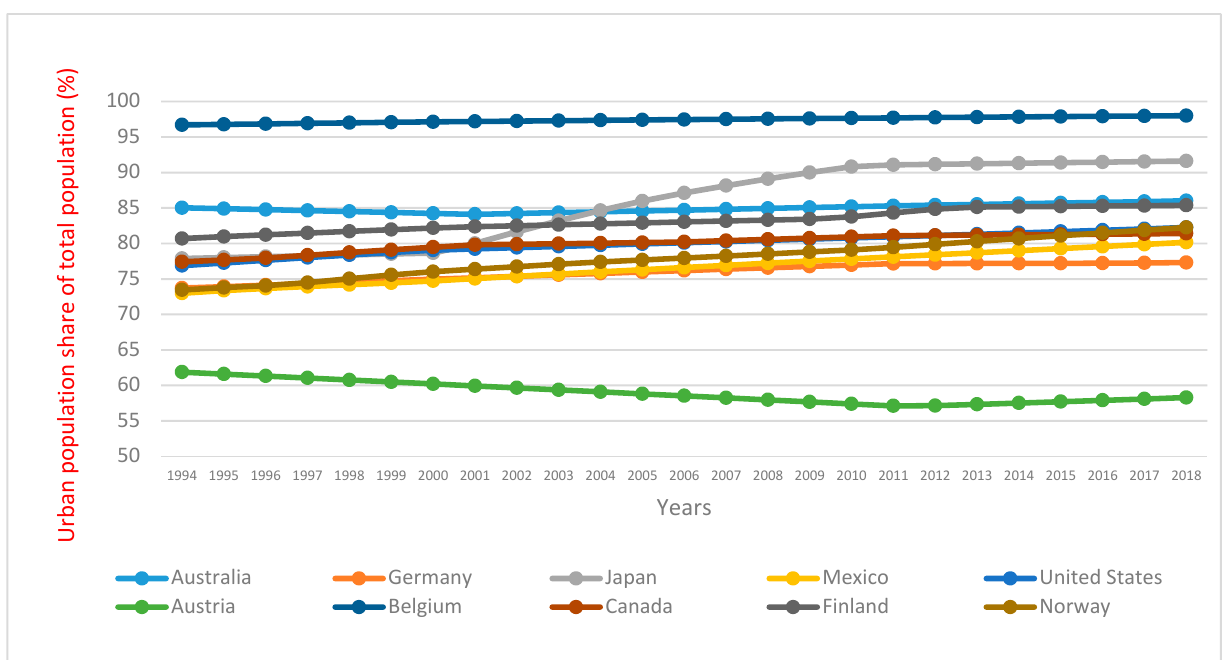
Figure A2. Ten OECD countries’ urbanization ratio (%).